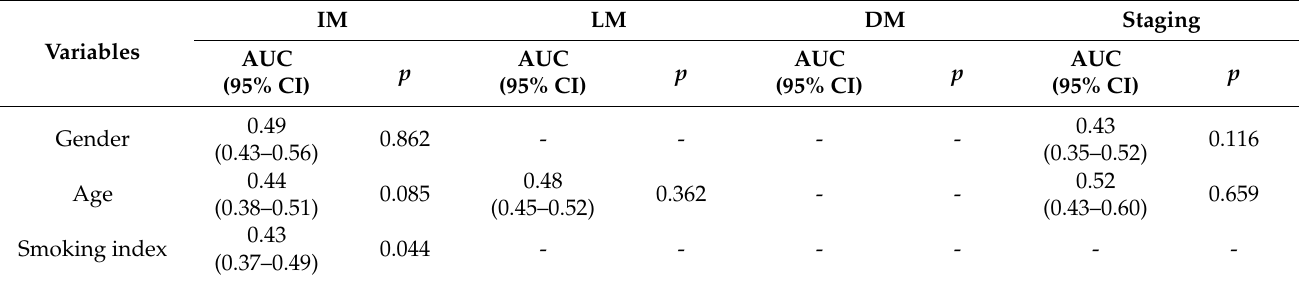
Figure 1. ROC curves of tumor markers for tumor metastasis and stage. ( A ) The ROC curve for gender, age, smoking index, CEA and CA199 in the diagnosis of intrapulmonary metastasis; ( B ) the ROC curve for age, CEA, CYFRA 21-1 and CA199 in the diagnosis of lymphatic metastasis. ( C ) the ROC curve for CEA and CA199 in the diagnosis of distant metastasis. ( D ) the ROC curve for gender, age, histologic classification, CEA, CYFRA 21-1, NSE and CA199 in the diagnosis of tumor stage. Table 8. Receiver operating characteristic (ROC) curves of influencing factors for tumor metastasis and clinical stage in patients with